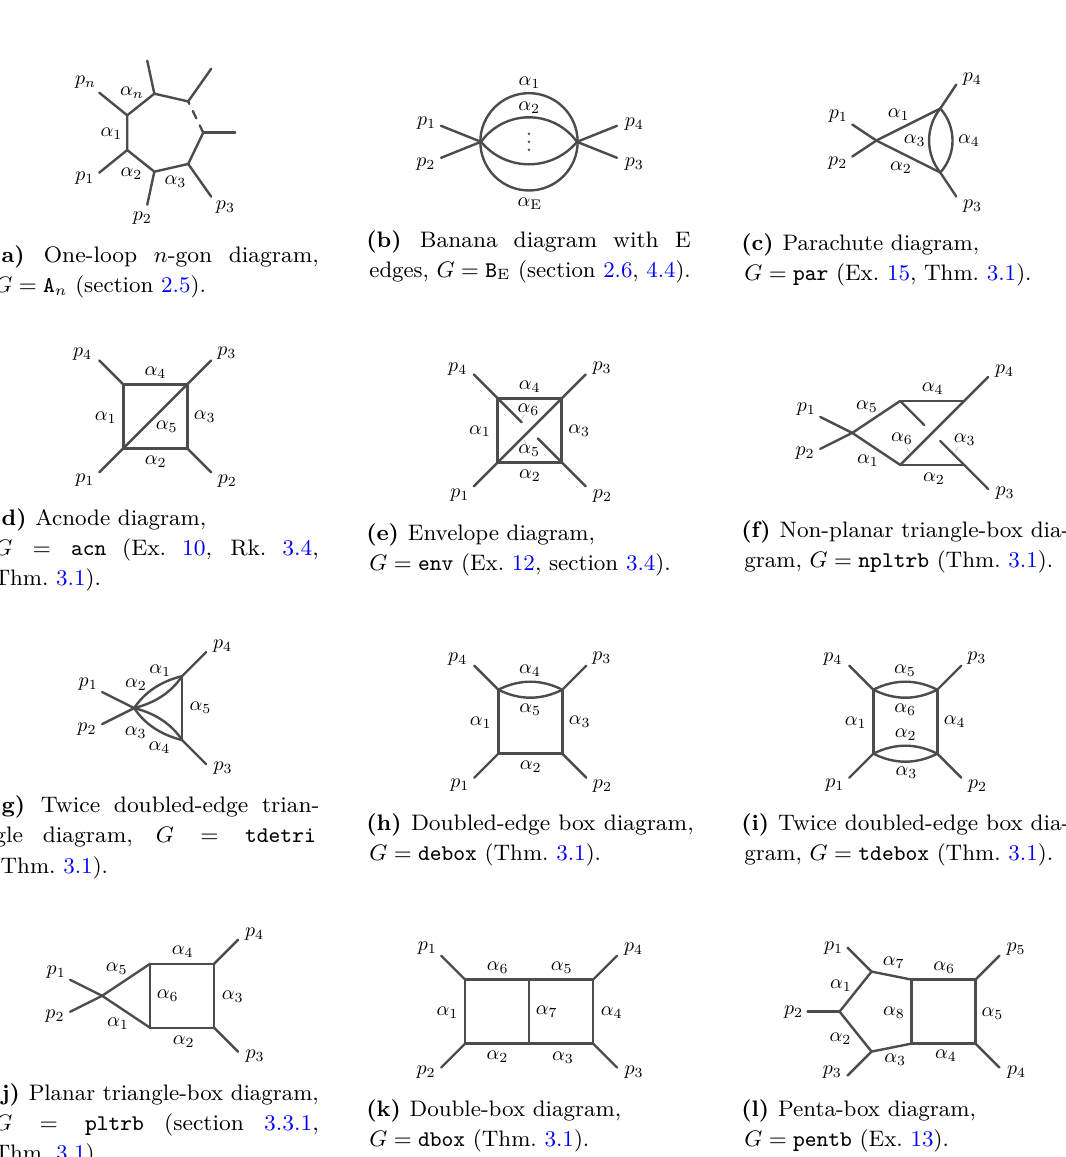
Figure 1. Summary of the Feynman diagrams considered in this